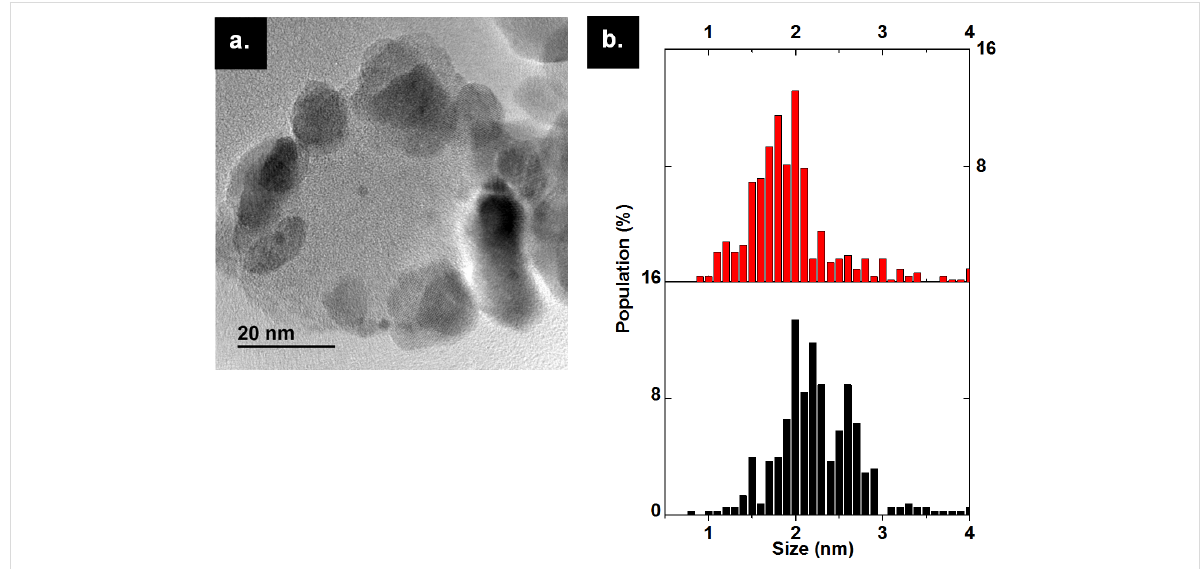
Figure 5: (a) TEM image of AuNP@ZrO 2 prepared by the deposition-precipitation method (B). (b) Comparison of size distribution of Au 25 (SG) 18 @ZrO 2 calcined at 400 °C for 12 hours under air (A 400 ) in red and AuNps@ZrO 2 (B) in